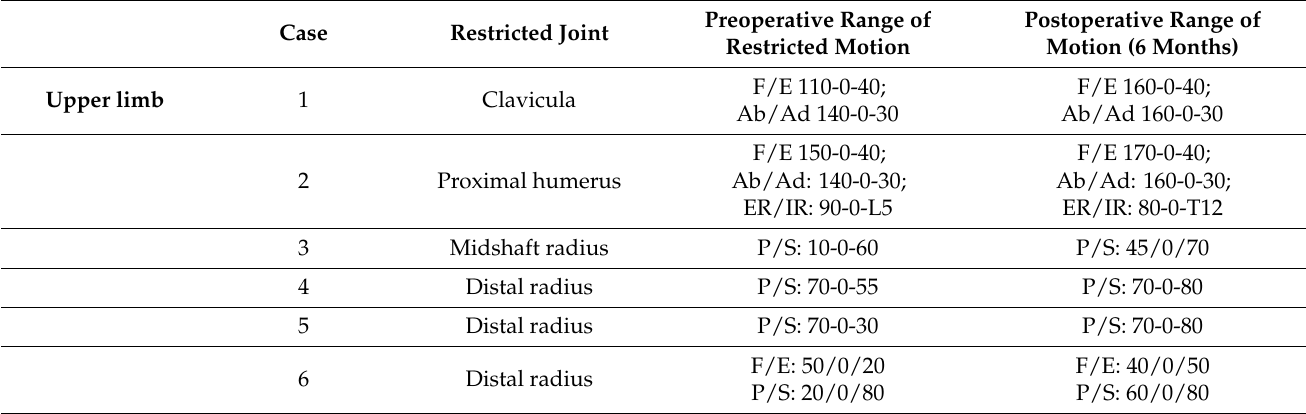
Table 3. Range of motion in the upper extremities before and 6 months after